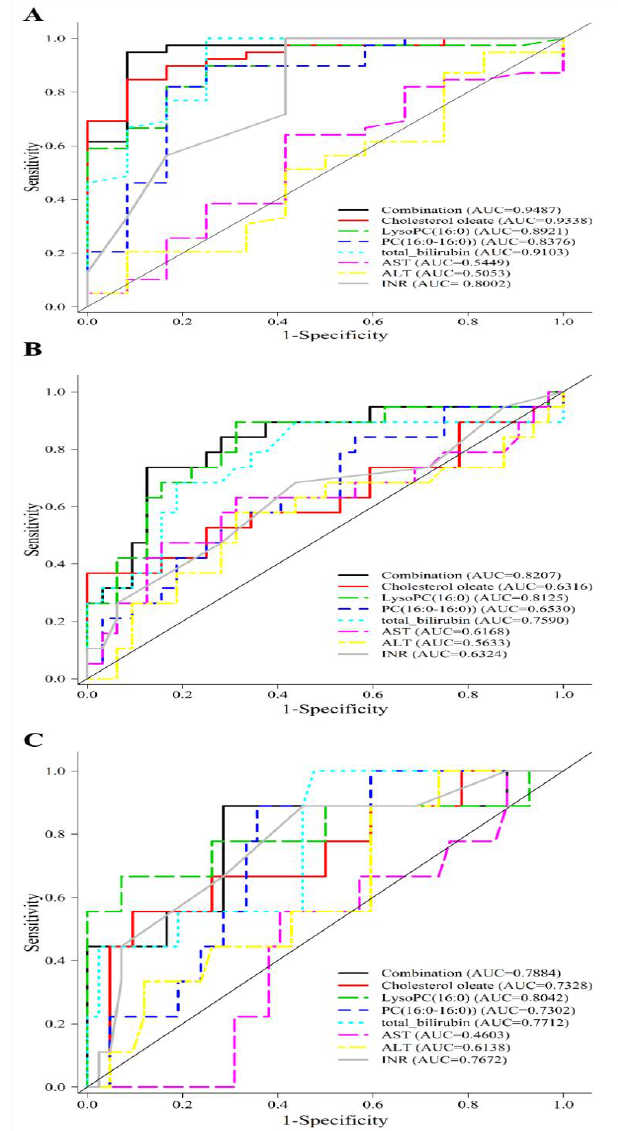
Figure 4. Prediction of early allograft dysfunction, all-cause in-hospital mortality, long hospital stay in study cohort. ( A ) A combination of cholesterol oleate, PC (16:0/16:0), and lysoPC (16:0) metabolites gives an AUC of 0.9487 in the prediction of EAD in the study group. ( B ) A combination of c cholesterol oleate, PC (16:0/16:0), and lysoPC (16:0) metabolites gives an AUC of 0.8207 in the prediction of hospital stay more than 45 days in the study group. ( C ) A combination of cholesterol oleate, PC (16:0/16:0), and lysoPC (16:0) metabolites gives an AUC of 0.7884 in the prediction of in-hospital mortality in the study group.